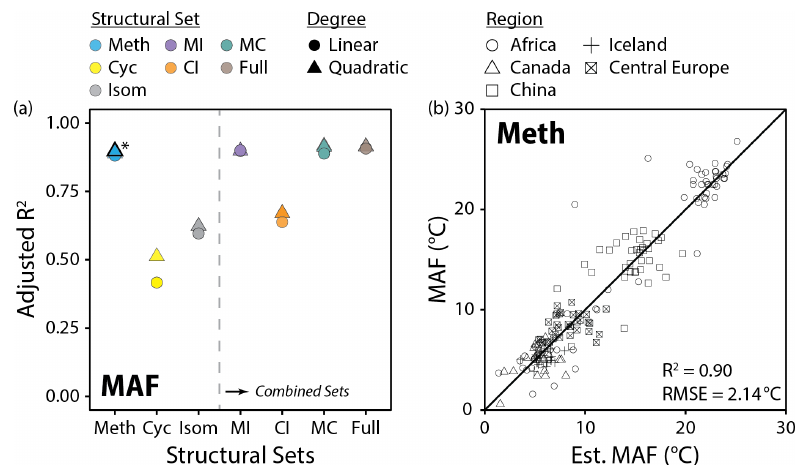
Figure 10. (a) Performance (adjusted R 2 ) of all linear and quadratic fits for the mean air temperature of months above freezing (MAF) and brGDGT fractional abundances (FAs) calculated within the basic (Meth, Cyc, Isom; left of dashed line) and combined (Meth–Isom (MI), Cyc–Isom (CI), Meth–Cyc (MC), and Full sets; right of dashed line) structural sets. Results of both the SFS/SBE and combinatoric fitting methods are plotted. The fit we suggest for general use (Meth set, quadratic, SFS/SBE; Eq. 10) is bolded and marked with an asterisk in (a) and plotted in (b) . “Est. MAF” is the MAF temperature estimated using this suggested